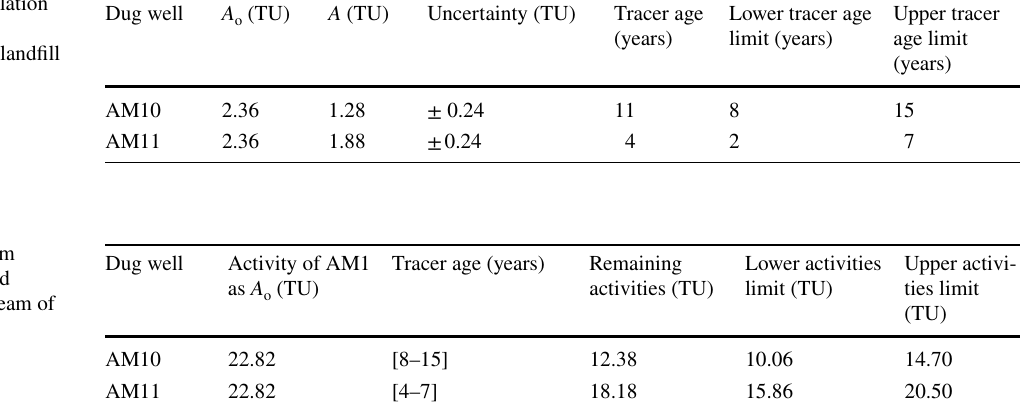
Table 3 Tracer age calculation for young ground waters collected downstream of landfill